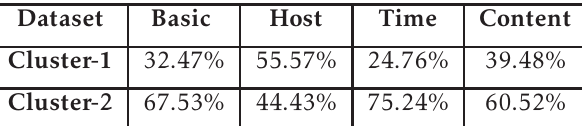
Table 3. Multiview Clustering Results